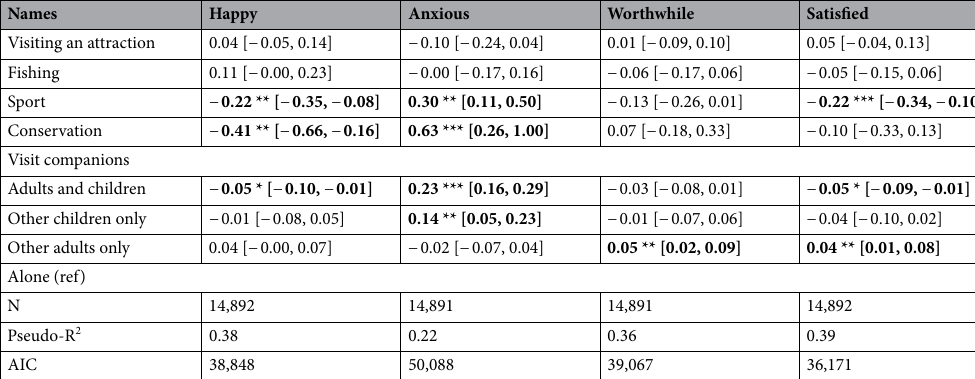
Table 1. Well-being by environmental features, exposure and experience. Fully adjusted linear mixed effects model (Step 3) results for each well-being outcome including natural and environmental features, exposure and experience. Full results, including covariates, are in Tables S4–S7. Note that a negative co-efficient for anxiety indicates disagreeing that the visit made them anxious. Models adjust for age, sex, perceived financial strain, limiting illness/disability, garden access, employment status, educational attainment, ethnicity, relationship status, dog ownership, survey wave, underlying well-being, travel origin, travel mode, travel time and country (random effect). *** p < 0.001; ** p < 0.01; * p < 0.05. Significant values are in